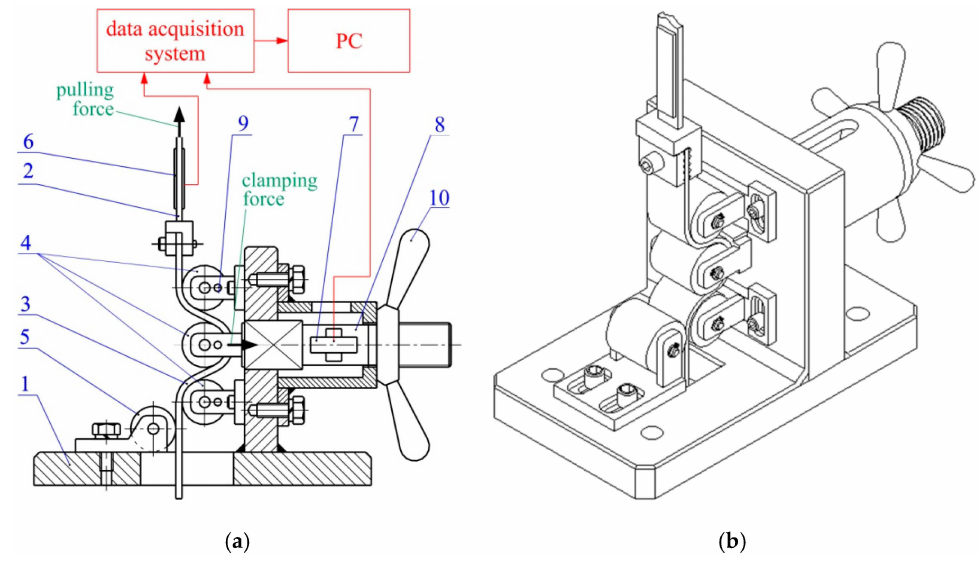
Figure 3. ( a ) diagram and ( b ) 3D model of the test device: 1—frame; 2—vertical tension member; 3—specimen; 4—working rolls; 5—supporting roll; 6,7—load cells; 8—horizontal tension member; 9—pin, 10—nut.